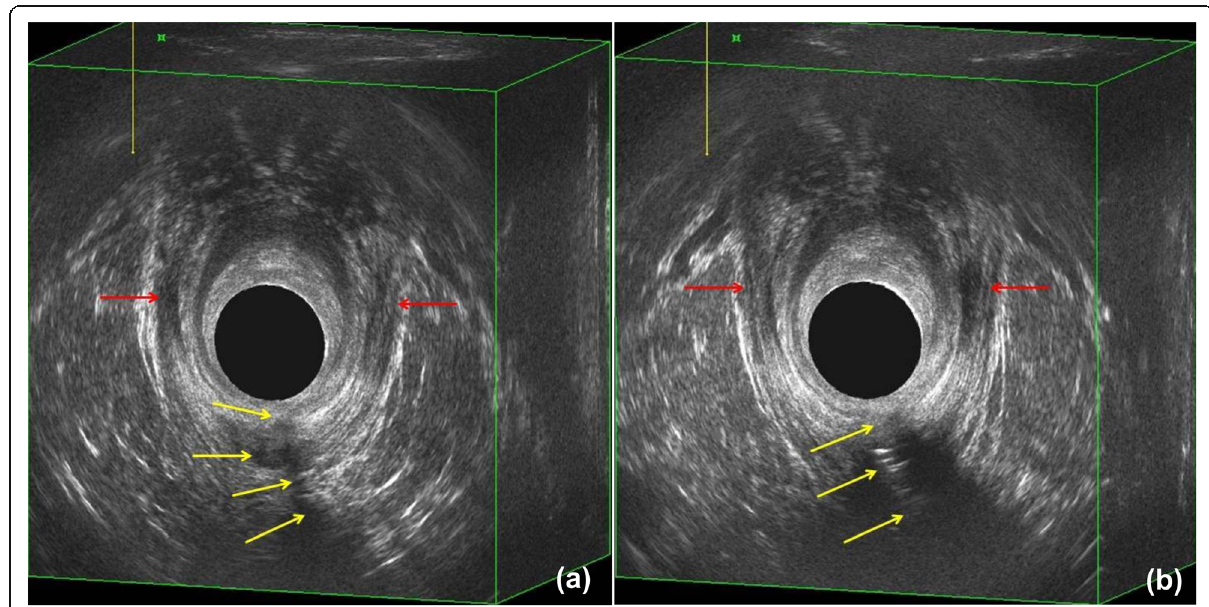
Fig. 7 3D TRUS image of a transsphincteric fistula (marked by yellow arrows) at the upper anal canal level. a Hypoechoic area before H 2 O 2 instillation. b Hyperechoic shadow after H 2 O 2 instillation. Red arrows demonstrate the puborectalis